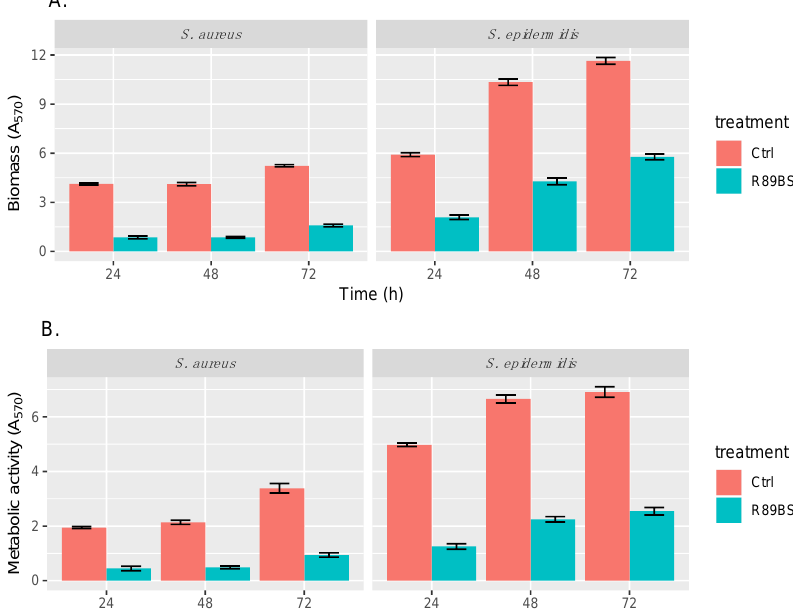
Figure 4. Anti-biofilm activity of R89BS deposited on the surface of silicone discs (SEDs) by direct physical adsorption. The anti-biofilm activity of R89BS-coated SEDs on Staphylococcus spp. biofilm formation was evaluated in terms of both biofilm biomass ( A ) and cell metabolic activity ( B ) after 24, 48, and 72 h.